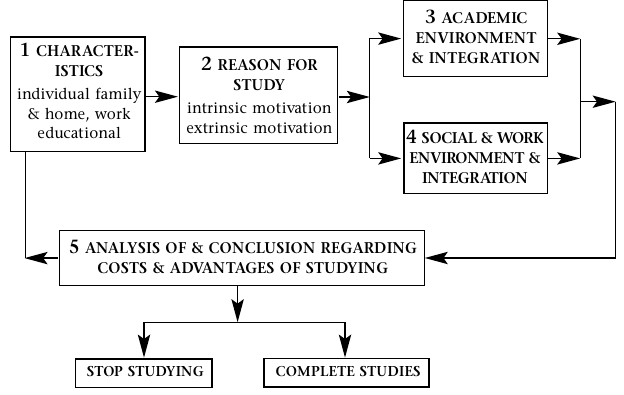
Figure 1: The Kember model of student drop-outs in distance education (adapted from Roberts et al., 1991, p.